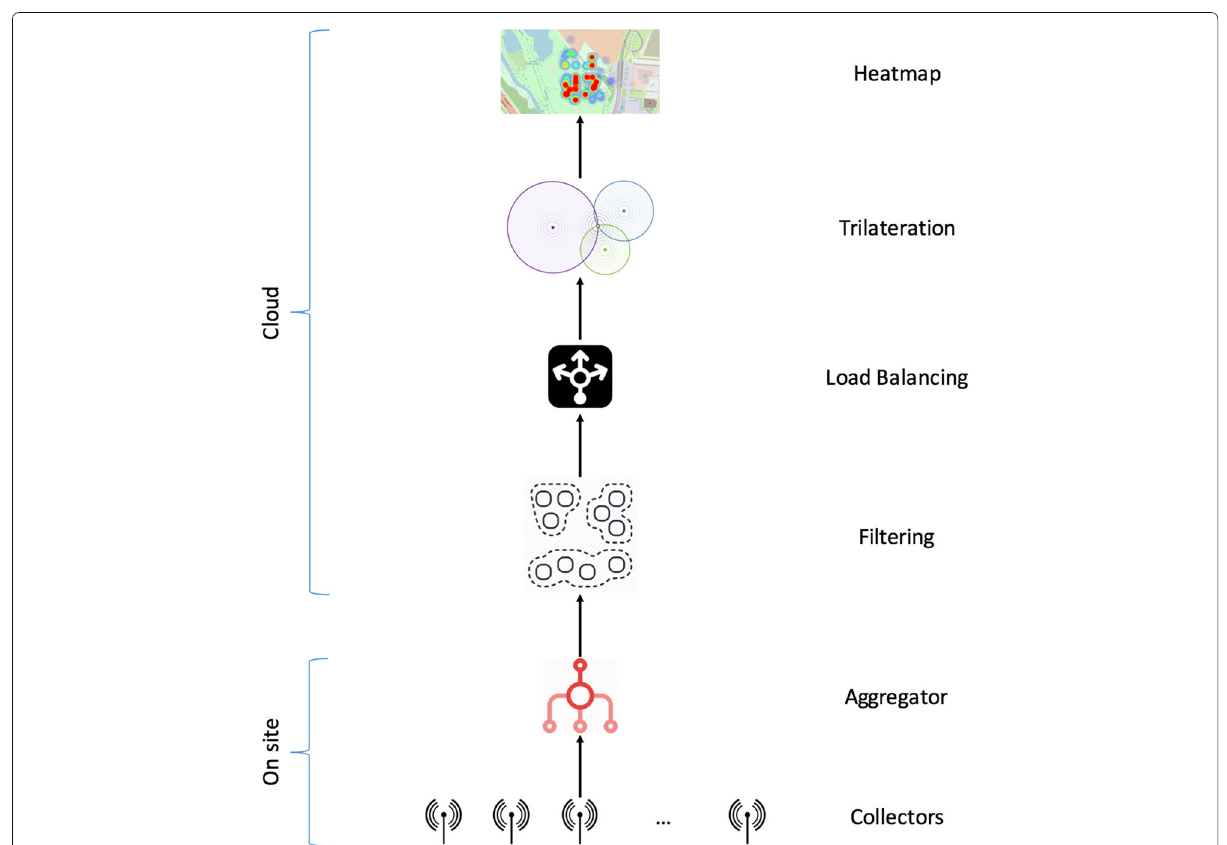
Fig. 1 High-level architecture. The STRAND application workflow